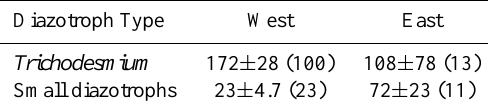
Table 3. Summary of mean areal rates (mean ± SE) of N 2 fix- ation by Trichodesmium and small diazotrophs in the western (longitude > 40 ◦ W) and eastern (longitude < 40 ◦ W) portions of our study area. Number of measurements shown in parenthe- ses. The regional difference was not significant for Trichodesmium ( p =0.4433, df =111) and highly significant for the small dia- zotrophs ( p =0.0093, df =32).